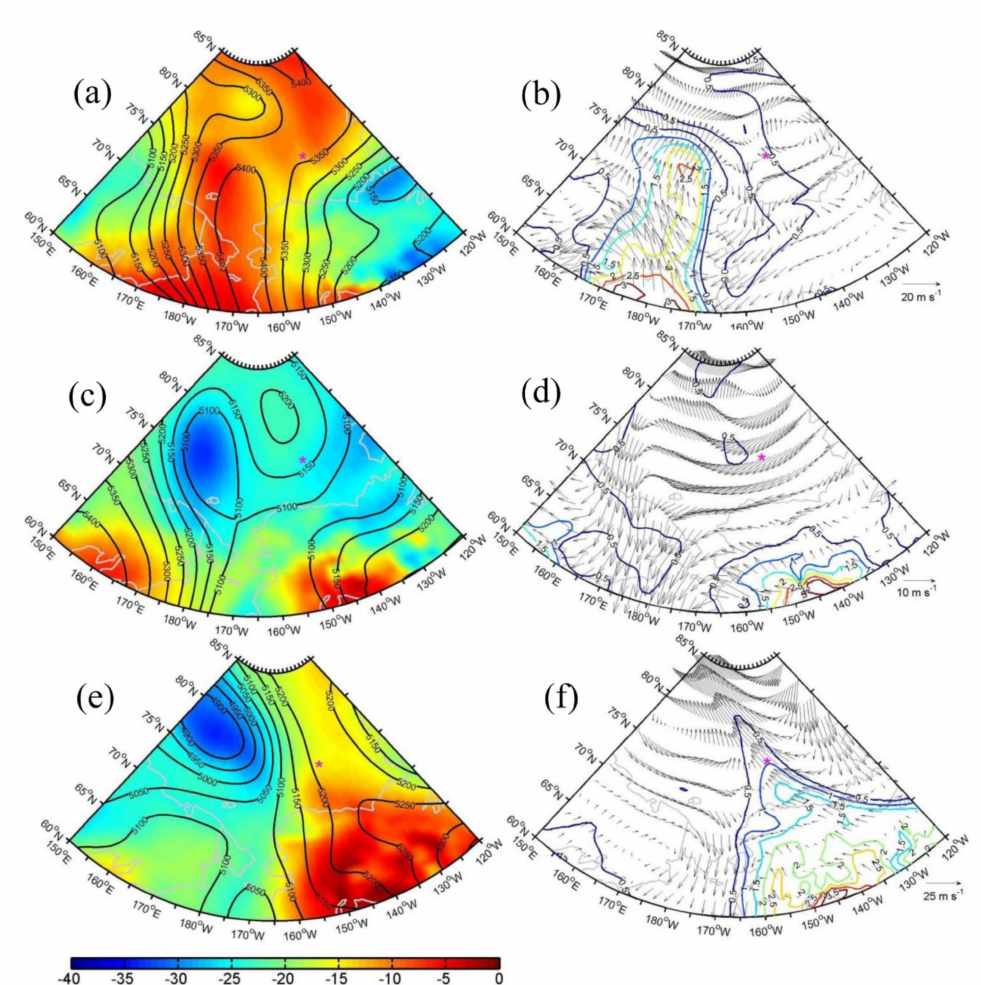
Figure 4. Spatial patterns of 500-hPa geopotential height (gpm) (contour) and 850-hPa temperature ( ◦ C) (shading) ( a , c , e ) and 850-hPa wind field (m s -1 ) (vector) and specific humidity (g / kg) (contour) ( b , d , f ) on 5 January 1998 ( a , b ); 15 January 1998 ( c , d ); 29 January 1998 ( e , f ) from the European Centre for Medium-Range Forecasts (ECMWF) Reanalysis (ERA)-Interim reanalysis. The pink asterisk denotes the SHEBA camp